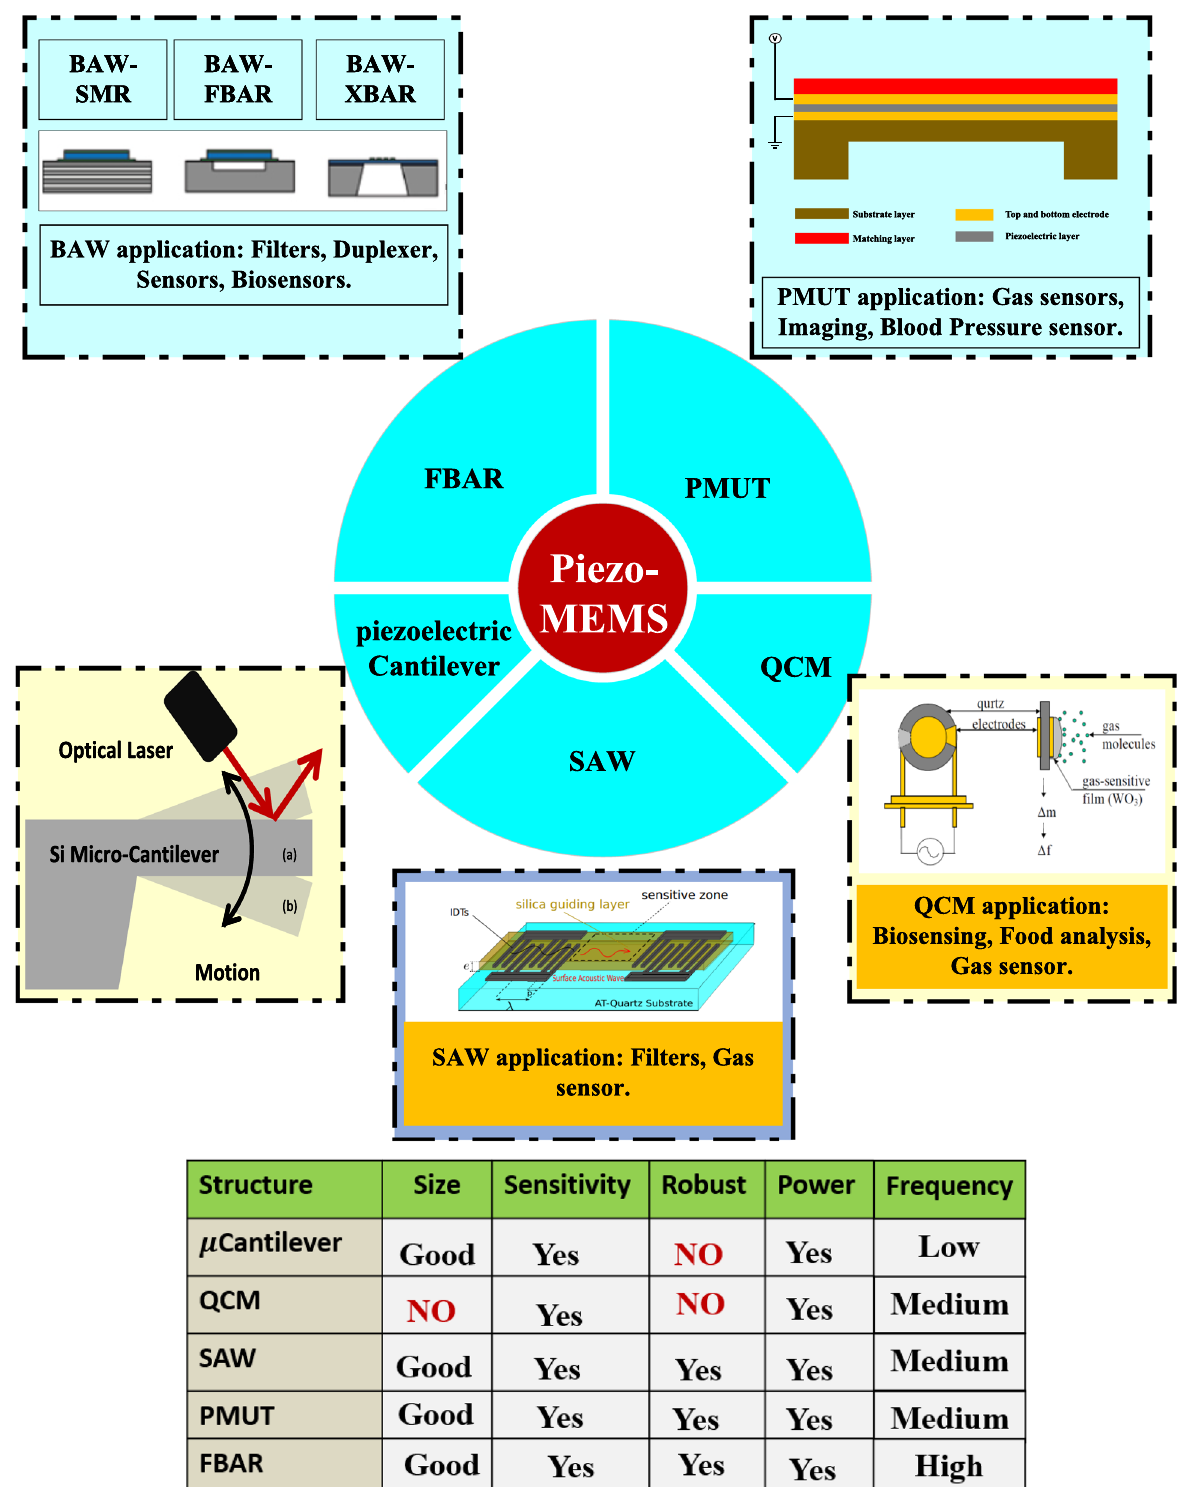
Fig. 7 The Schematic for the film bulk acoustic wave, Piezoelectric micromachined ultrasonic transducer, Micro-cantilever, Quartz Crystal microbalance [346], Surface acoustic wave